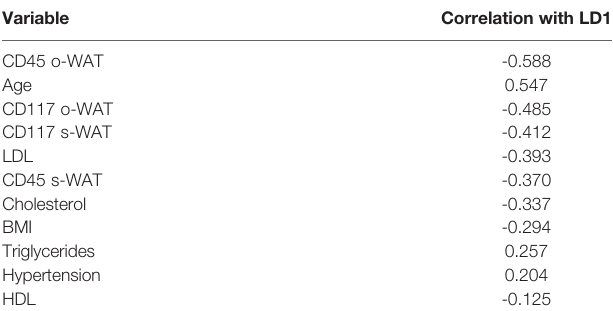
TABLE 2 | Correlation of each variable with LD1. BMI (body mass index), o-WAT (omental white adipose tissue), s-WAT (subcutaneous white adipose tissue), LD1 (linear discriminant 1).